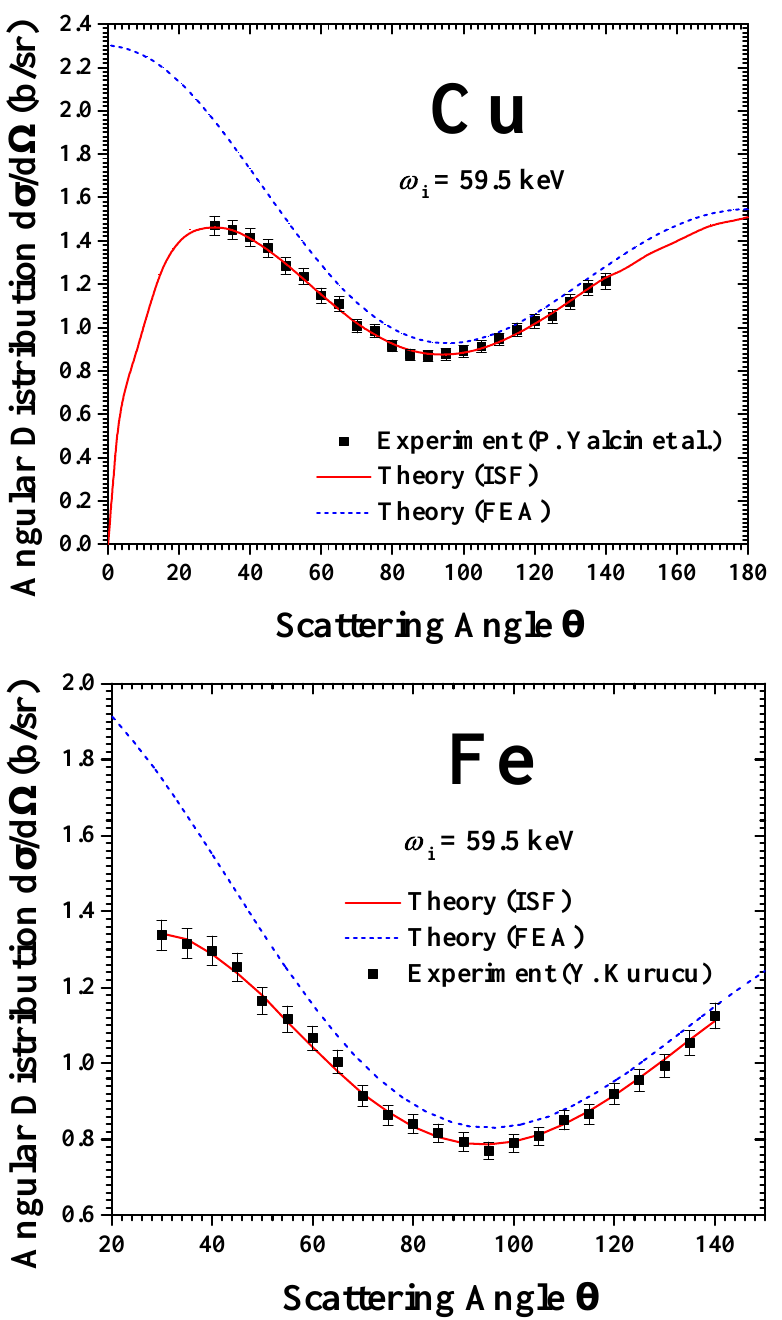
Figure 4. Angular distribution for Compton scattering process at incident photon energy ω i = 59.5 keV for Fe and Cu. In this figure, the vertical axis labels differential cross sections d σ / d Ω f , and the horizontal axis labels the scattering angle θ . The experimental measurements from reference [80,81] and the theoretical predictions of FEA and ISF approaches [81,82] are plotted in this